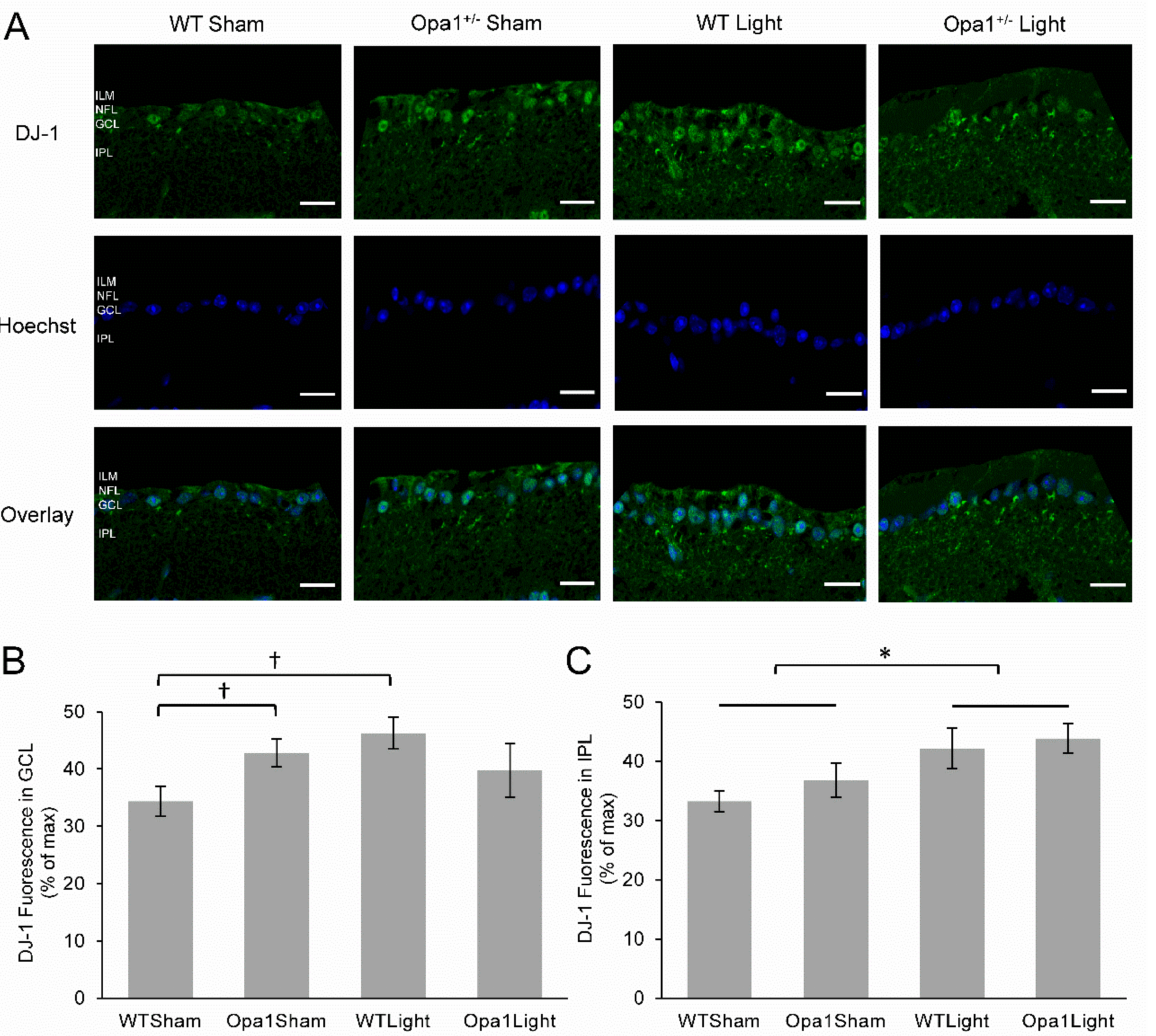
Figure 7. DJ-1 expression was upregulated in the IPL Following PBM: ( A ) Representative cross-sections of the GCL and IPL taken at 60 × magnification. The top row shows DJ-1 staining in green, the middle row shows the nuclear stain, and the bottom row shows an overlay of the two stains. ILM: inner limiting membrane; NFL: nerve fiber layer; GCL: ganglion cell layer; IPL: inner plexiform layer. Scale bar represents 20 µ m. ( B ) Quantification of DJ-1 fluorescence revealed upregulation in the GCL of retinas from sham-treated Opa1 +/ − mice and light-treated WT mice when compared to the sham-treated WT group. ( C ) There was upregulation of DJ-1 in the IPL in response to 670 nm light treatment in both WT and Opa1 +/ − mice compared to their sham-treated counterparts. WT Sham ( n = 3), WT Light ( n = 7), Opa1 +/ − Sham ( n = 5) and Opa1 +/ − Light ( n = 3). * p < 0.05 main effect of treatment, two-way ANOVA; † p < 0.05, Mann-Whitney